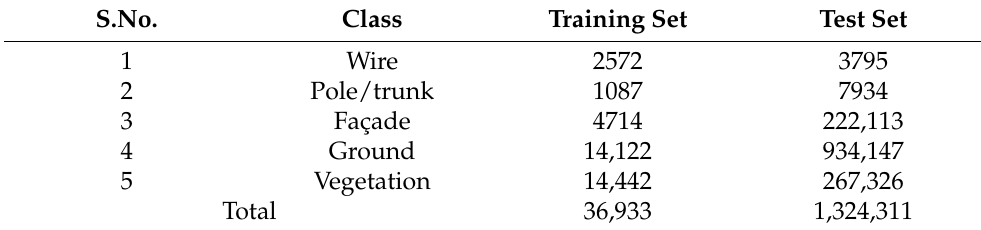
Table 3. For the Oakland 3D PC Dataset, the number of samples per class. S.No. Class Training Set